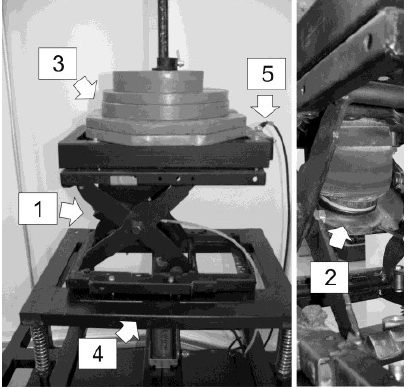
Fig. 6. Experimental test stand 1- suspension mechanism, 2 - air spring, 3 - load mass 4 - vibrating table, 5 - laser sensor